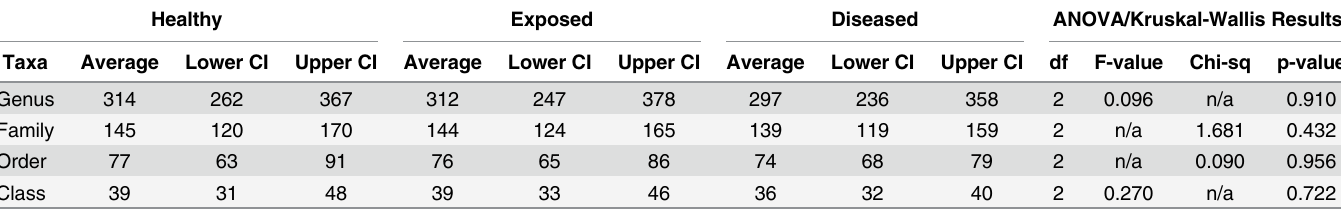
Table 2. Mean bacterial richness on diseased and healthy corals.